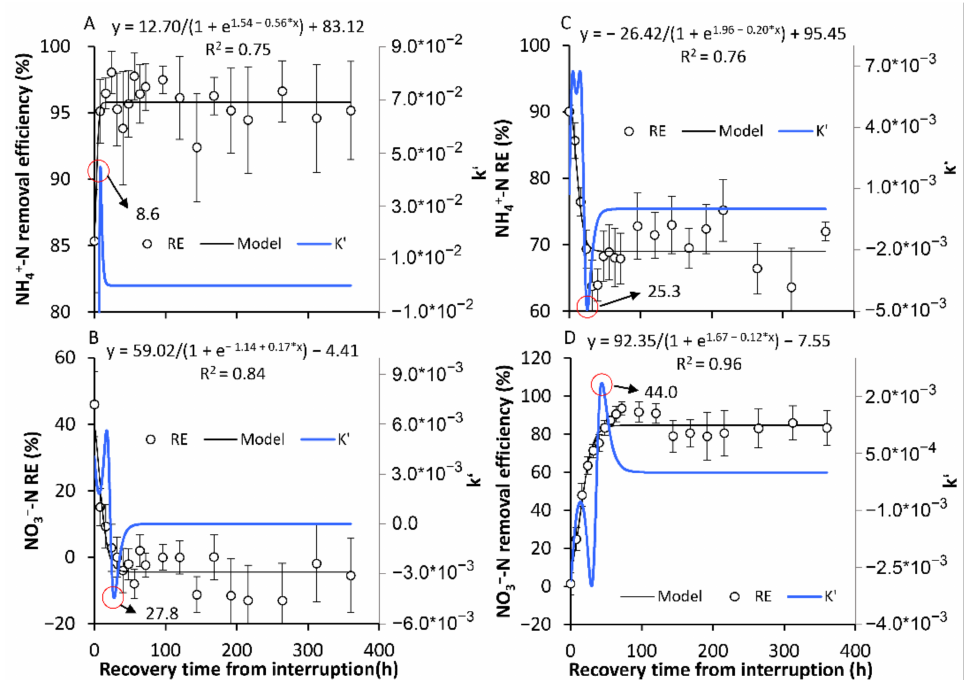
Figure 7. The recovery back to the original stable state (SS) of the removal efficiency of NH 4+ -N and NO 3 − -N after the seven-day aeration or no aeration interruption. ( A , B ) show the recovery of the original SS of the removal efficiency of NH 4+ -N and NO 3 − -N, respectively, in the AE-D reactors; ( C , D ) show the recovery of the original SS of the removal efficiency of NH 4+ -N and NO 3 − -N, respectively, in the AN-D reactors. The red circle is the position of the inflection point, and the number indicated by the arrow is the corresponding time of the inflection point. (sample number: